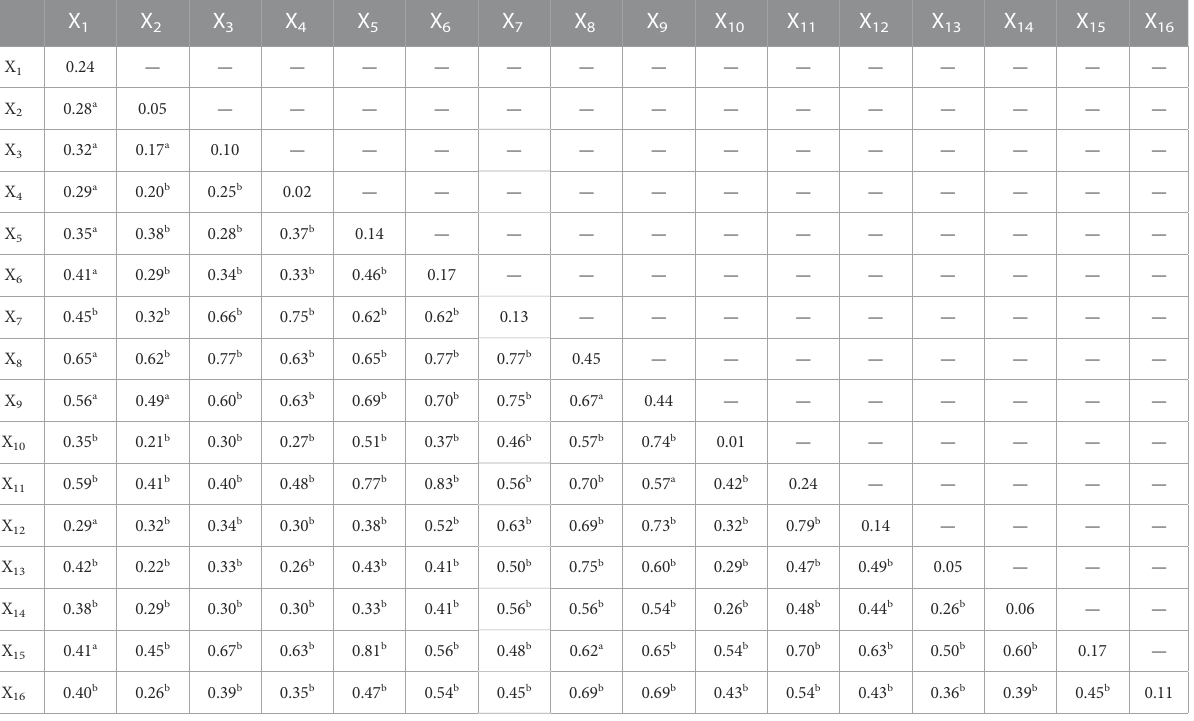
TABLE 5 Interaction detection of each in fl uence